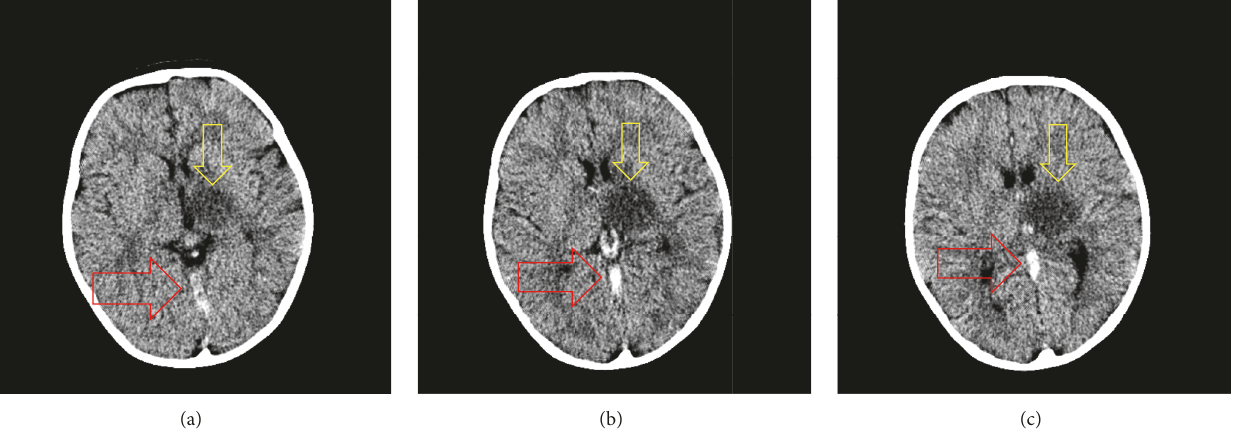
Figure 1: Axial noncontrast CT at the level of basal ganglia. These scans demonstrate dense clot sign which show a dark area (yellow arrows) where the infarct of the left thalamus is located due to thrombosis of internal cerebral veins and straight sinus (red arrows).